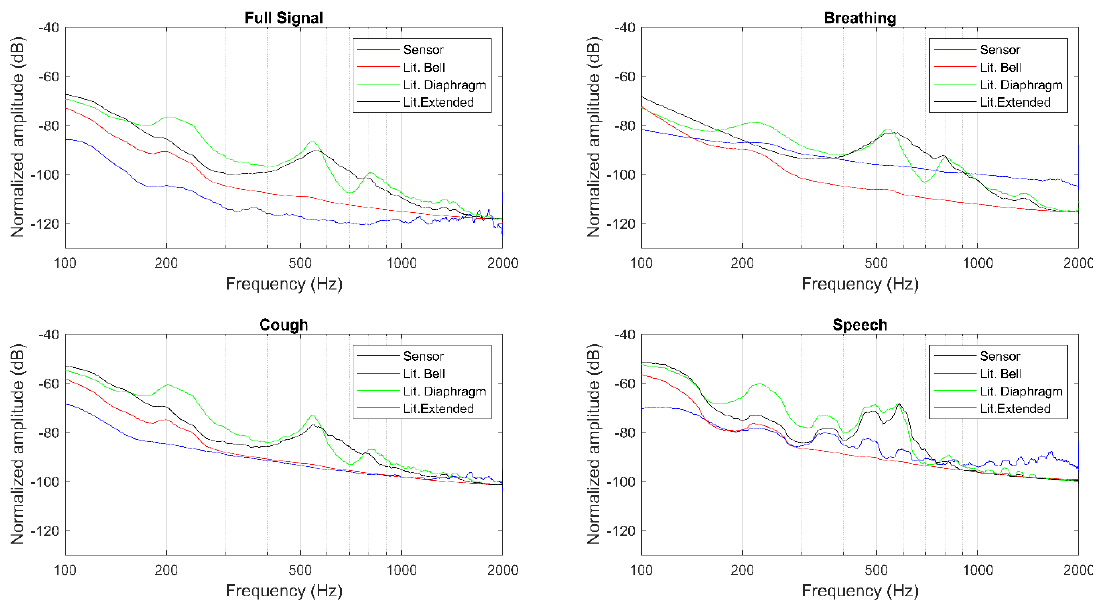
Figure 6. Magnitude spectra for position 18.